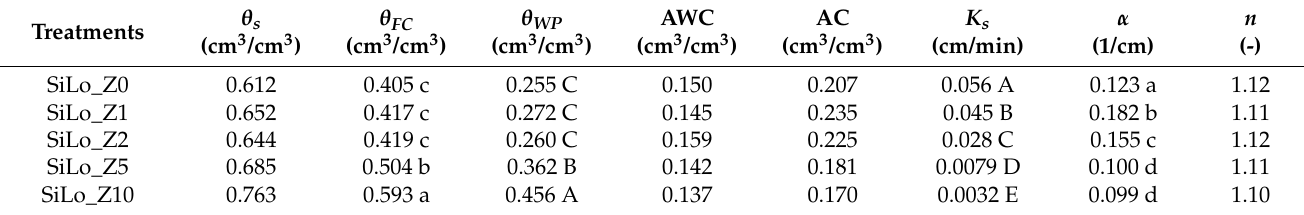
Table 2. Soil hydrophysical properties: (i) volumetric water content at saturation ( θ s ), (ii) water content at field capacity ( θ FC ), (iii) water content at permanent wilting point ( θ WP ), (iv) available water content (AWC), (v) air capacity (AC), (vi) hydraulic conductivity at saturation ( K s ), and (vii) van Genuchten’s model parameters α and n , obtained from experimental SWRCs and with reference to the selected soil–zeolite mixtures.